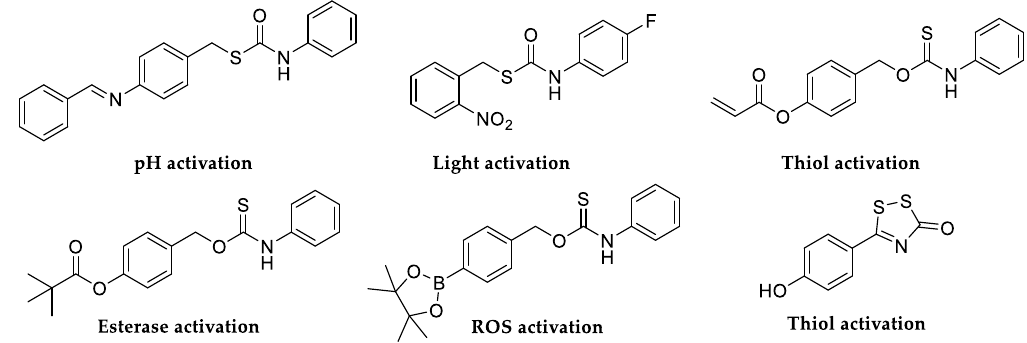
Figure 3. Selected small molecule incorporating H 2 S donors and their chemical motifs.